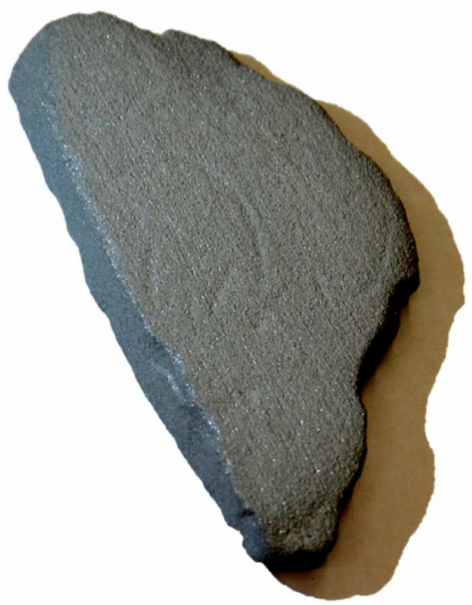
Figure 5. Replica in alumide.